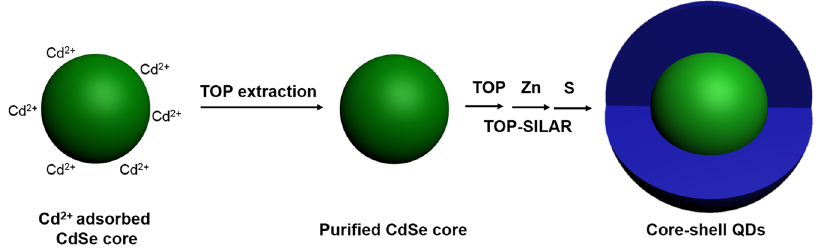
Figure 1. The growth scheme of modified TOP-SILAR method coupled with TOP extraction process using Cd 2 + adsorbed CdSe